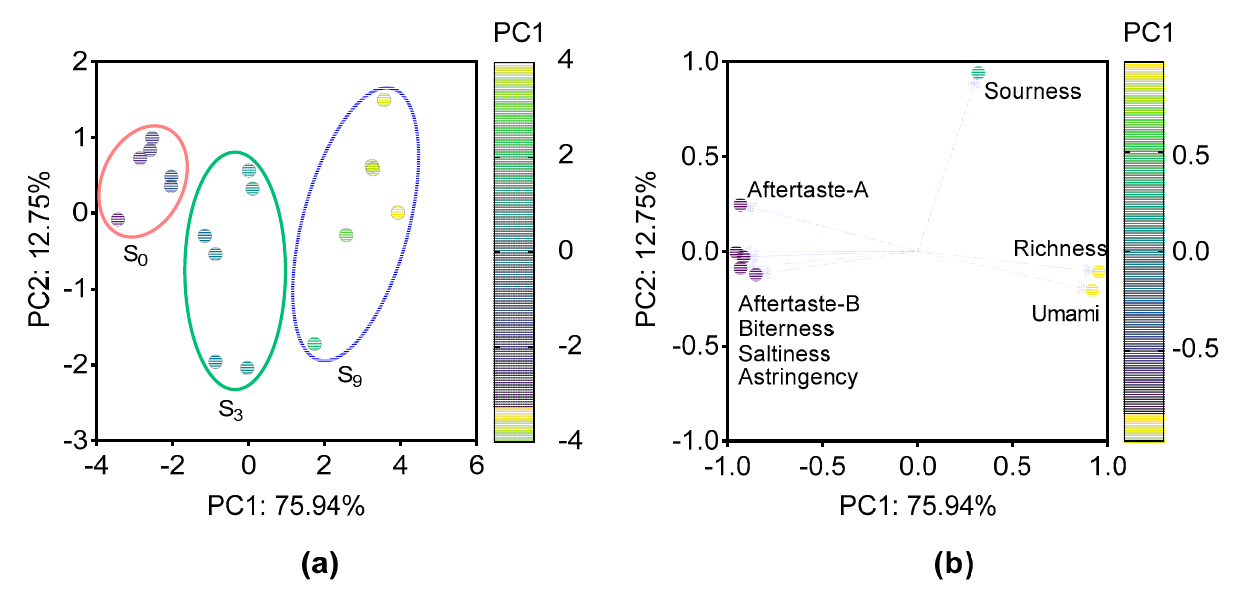
Figure 4. PCA from E-tongue data of largemouth seabass muscle with different salinity. ( a ) Score plot; the three groups are circled by different ovals; ( b ) loading plot. The color of each point represents the score along the PC1 direction.